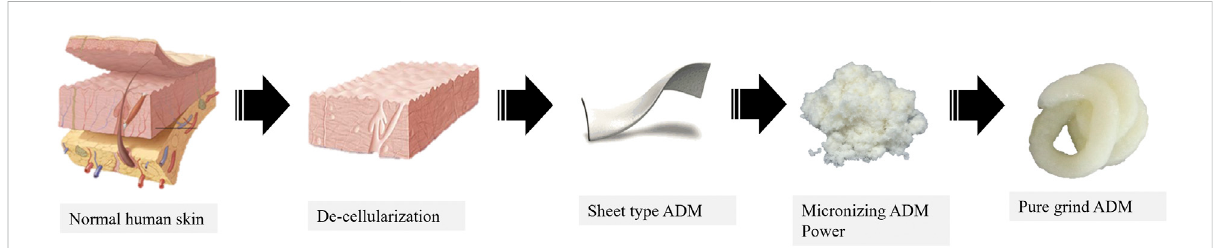
FIGURE 1 The pure-grind acellular dermal matrix (ADM). Based on normal human skin, sheet-type ADM was acquired after several procedures, including de-cellularization. Pure-grind ADM was made with powdered micronized ADM with uniform particle size.